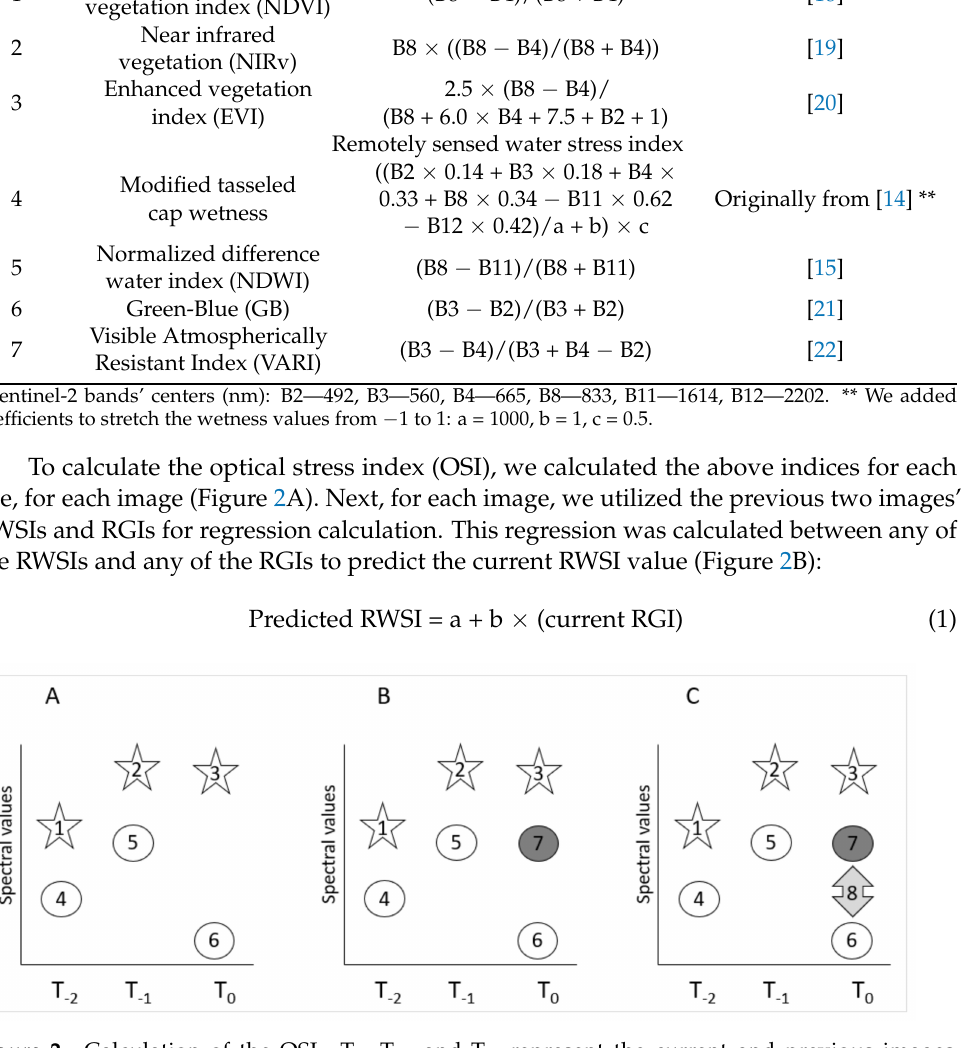
Figure 2. Calculation of the OSI—T 0 , T -1, and T -2 represent the current and previous images, respectively, while 1–3 and 4–6 represent the growth index (star) and the water stress index (circle), respectively. ( A ) Calculation of both indices for each image. ( B ) The current growth index (#3) is used to predict the current water stress index (#7) based on the regression between the previous growth (#1–2) and the water stress (#4–5) values. ( C ) This predicted value (#7) is subtracted from the current water stress value (#6) to show the current OSI value